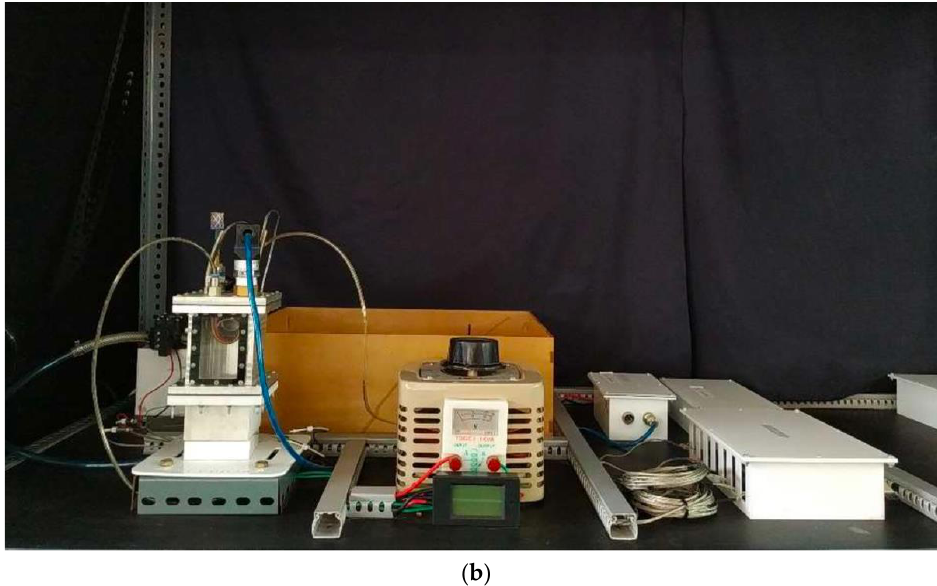
Figure 1. Experimental facility by ( a ) schematic diagram and ( b ) system configuration [27].